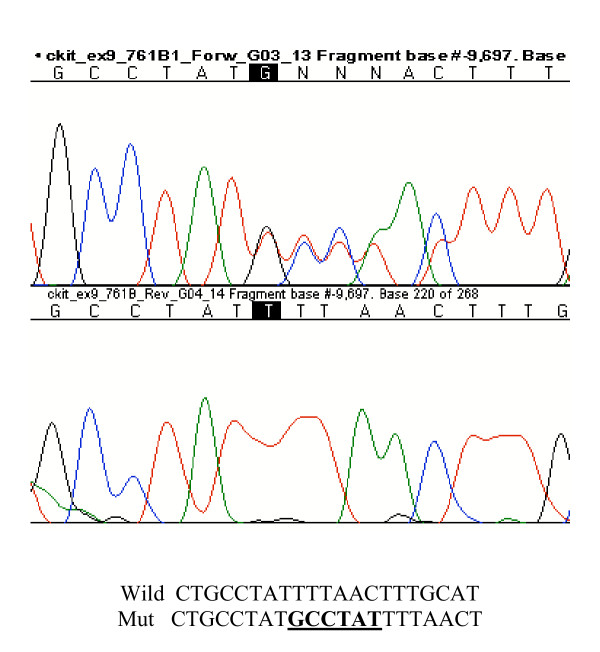
DNA sequence of part of exon 9 of c-kit for control (lower) and patient tumour (upper) samples. The patient's tumour sample contained a GCCTAT duplication